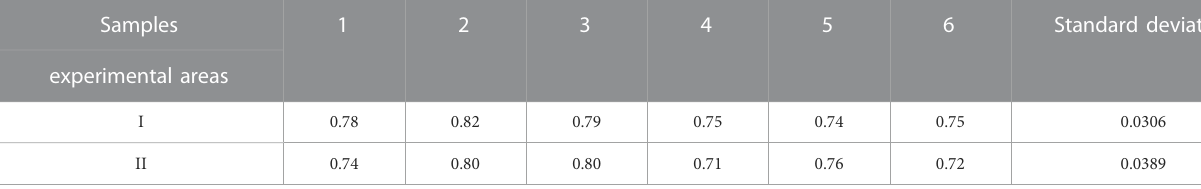
TABLE 6 Standard deviation based on Left-Right of each data in experimental area I and II. Samples